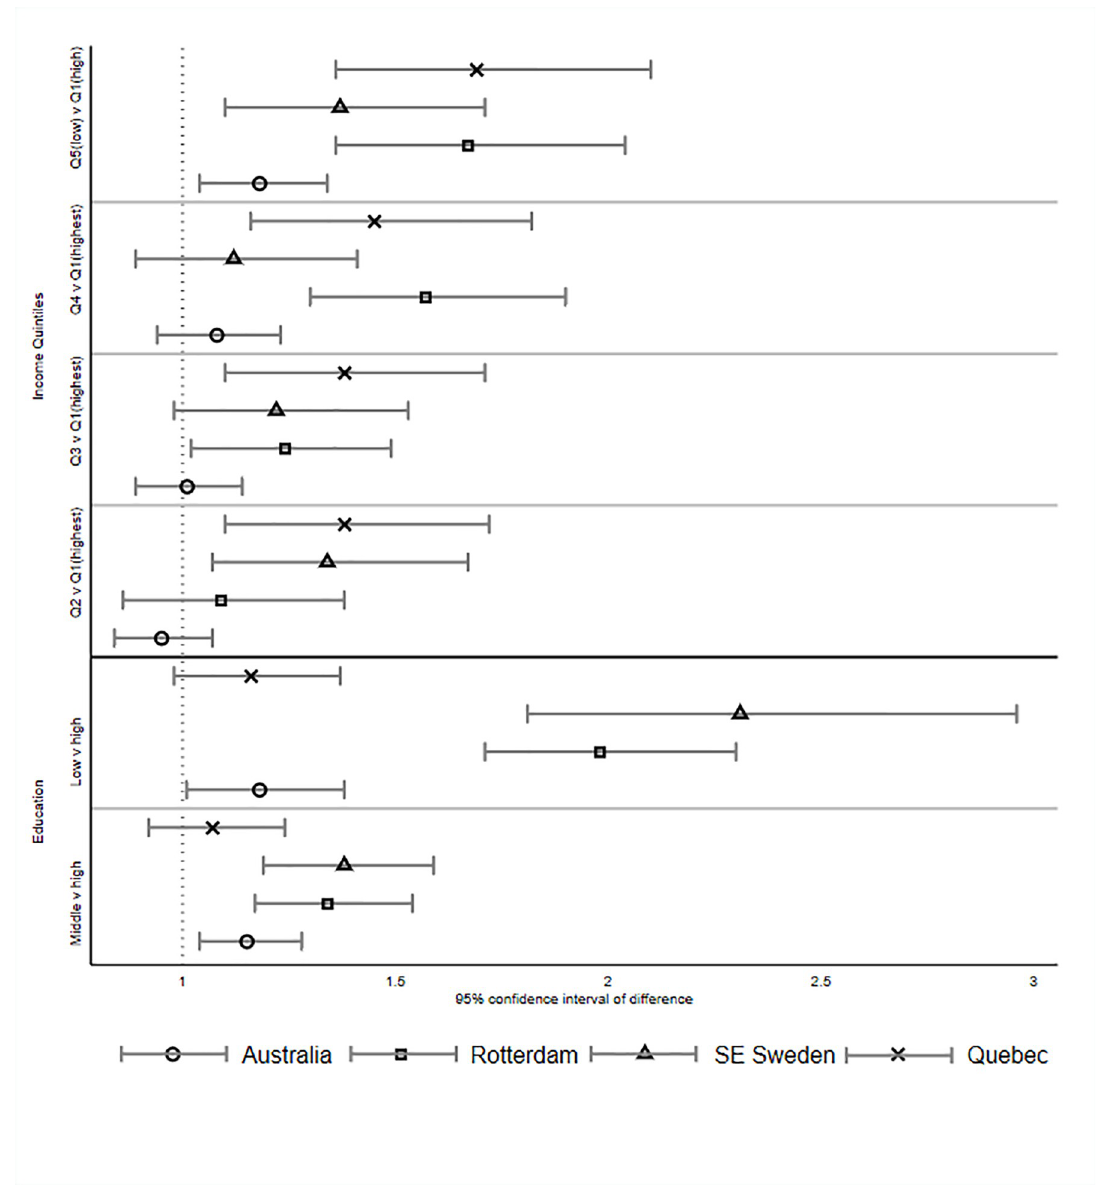
Fig 1. Forest plots illustrating inequalities in child dental caries by income and maternal education. Forest plots showing the association between (1) household income and child dental caries comparing the highest income to the each of the four lower categories; (2) mother’s education and child dental caries with the highest education category compared to the middle level and lowest level. Slope Index of Inequality (SII) SII by maternal education and income are illustrated for each cohort in Fig 2. For maternal education, the strongest gradient was in Rotterdam (SII = -45), estimating a 45% difference in caries prevalence when comparing the children whose mothers had the lowest level of educa- tion to the highest. Shallower gradients for Que´bec, Southeast Sweden, and Australia (SII = -30, -16, -15, respectively) reflected less difference in prevalence of child dental caries accord- ing to maternal education. For income quintiles, the gradients for Que´bec and Rotterdam